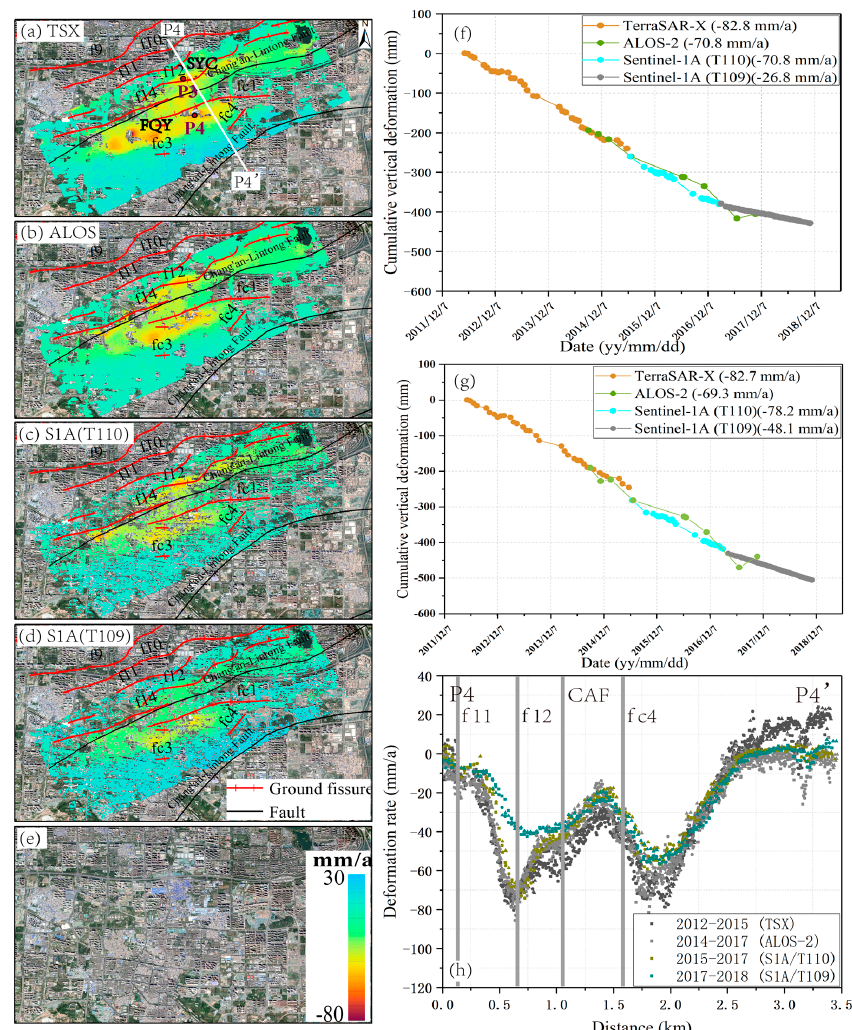
Figure 8. Land subsidence in the SYC-FQY area, located in the south-west sector of Xi’an city. ( a ) From 2012 to 2015 with the TerraSAR-X dataset; ( b ) from 2014 to 2017 with the ALOS-2 dataset; ( c ) from 2015 to 2017 with the Sentinel-1A (T110) dataset; ( d ) from 2017 to 2018 with the Sentinel-1A (T109) dataset; ( e ) Google Earth image; ( f ) and ( g ) cumulative time series deformations at the feature point P3 and P4, respectively, whose positions are marked in (a); (h) annual deformation rates from different band datasets along the profile P4P4’ from 2012 to 2018, whose position is marked in (a).